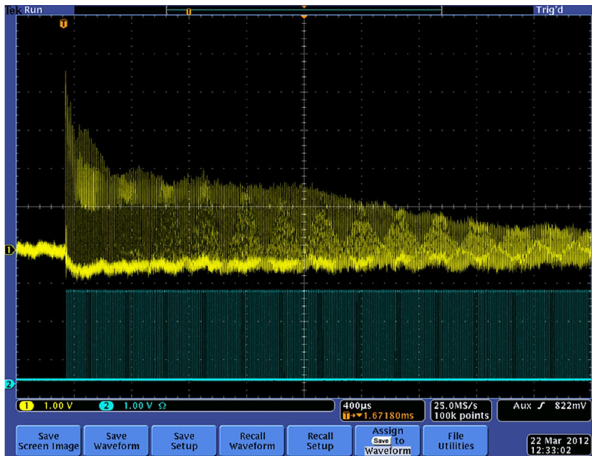
FIG. 31. Typical circulating beam signal with yellow color.